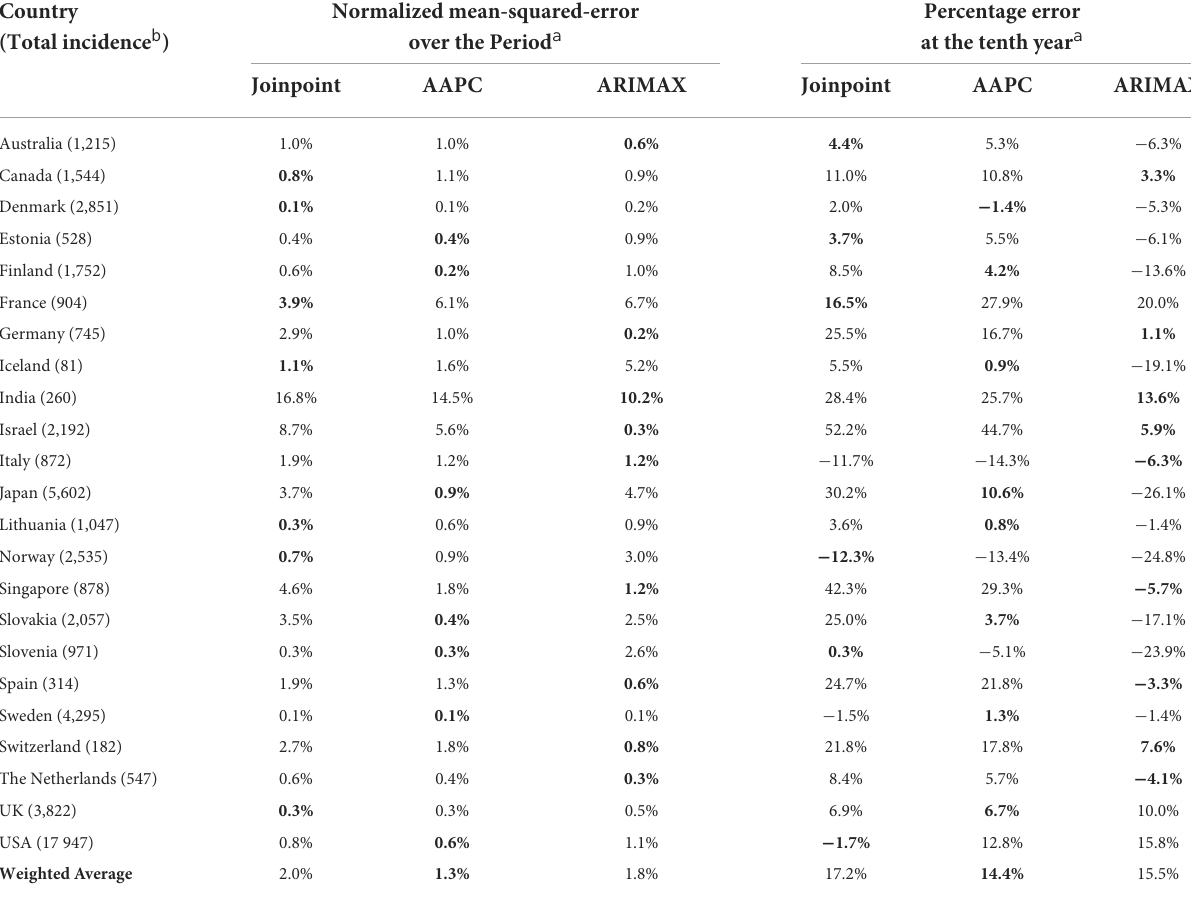
TABLE 3 Comparison between actual and 10-year projected incidence on colorectal